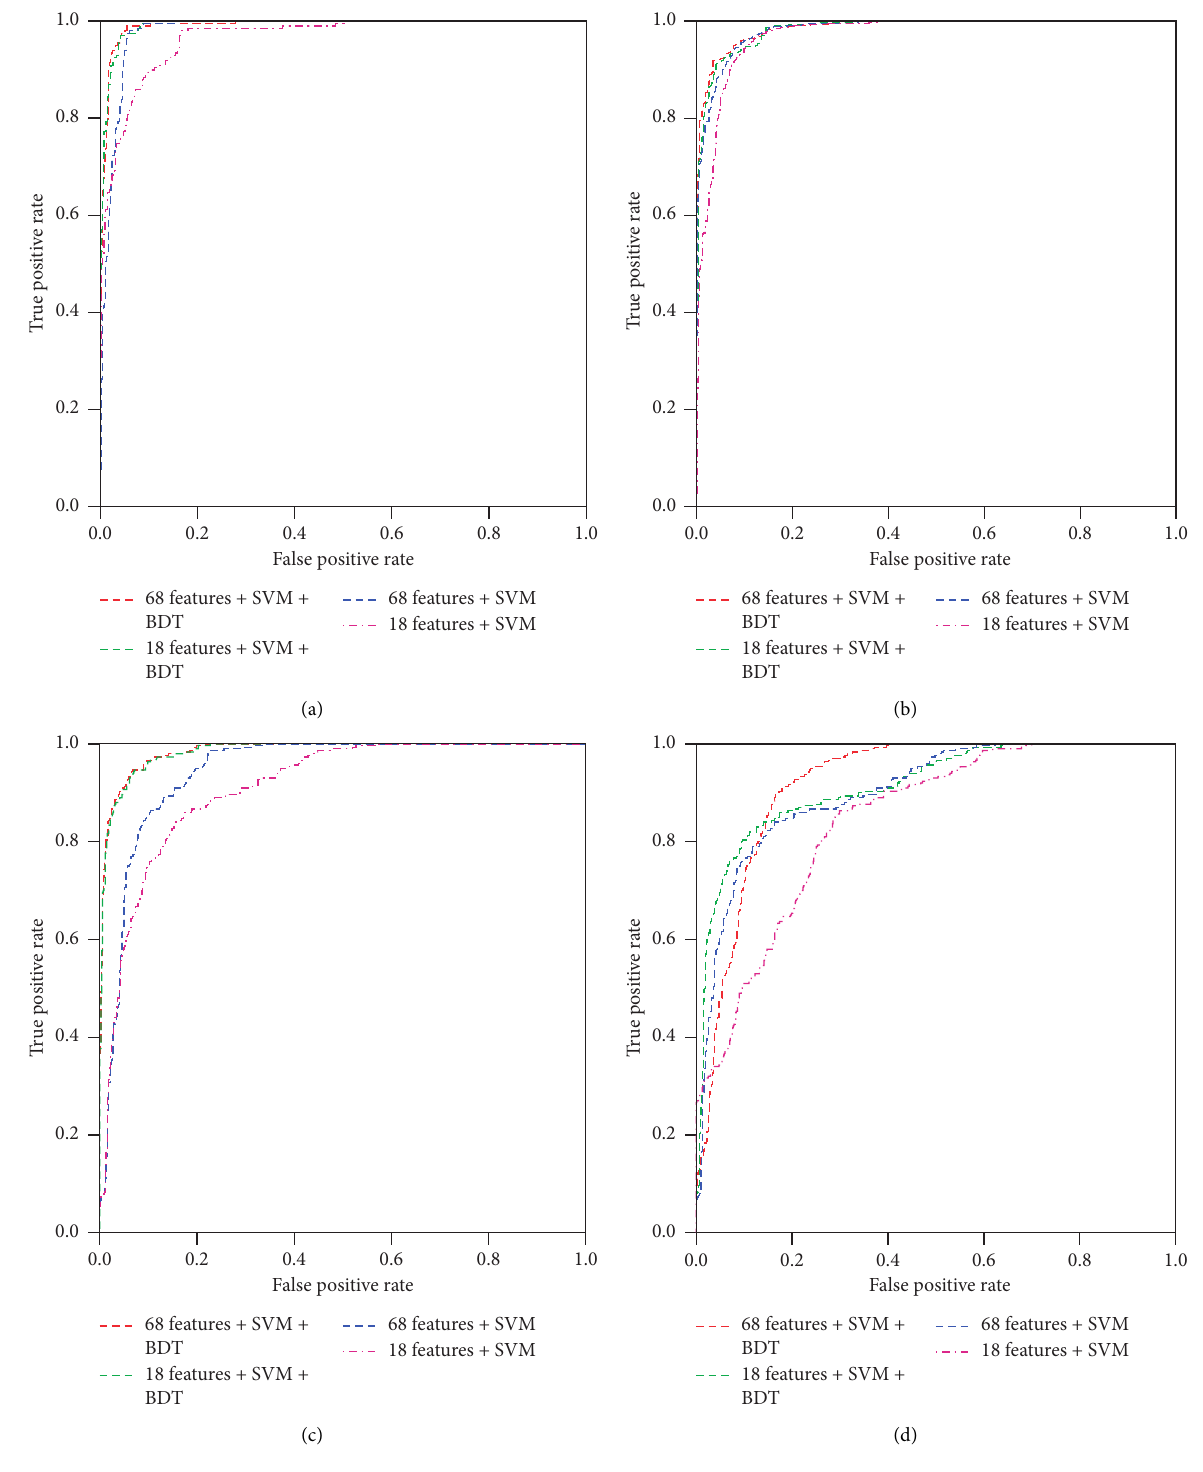
Figure 8: ROC curves of moving object classification results. (a) Vehicle, (b) pedestrian, (c) bicycle, and (d) method, and vice versa. AUC values and the run time of four methods are listed in Table 4. The run time denotes the total time cost of both the feature extraction and Figure 8. The larger the area under the ROC curve (AUC) classification stages. We can see that in terms of the SVM- is, the better is the performance of the classification